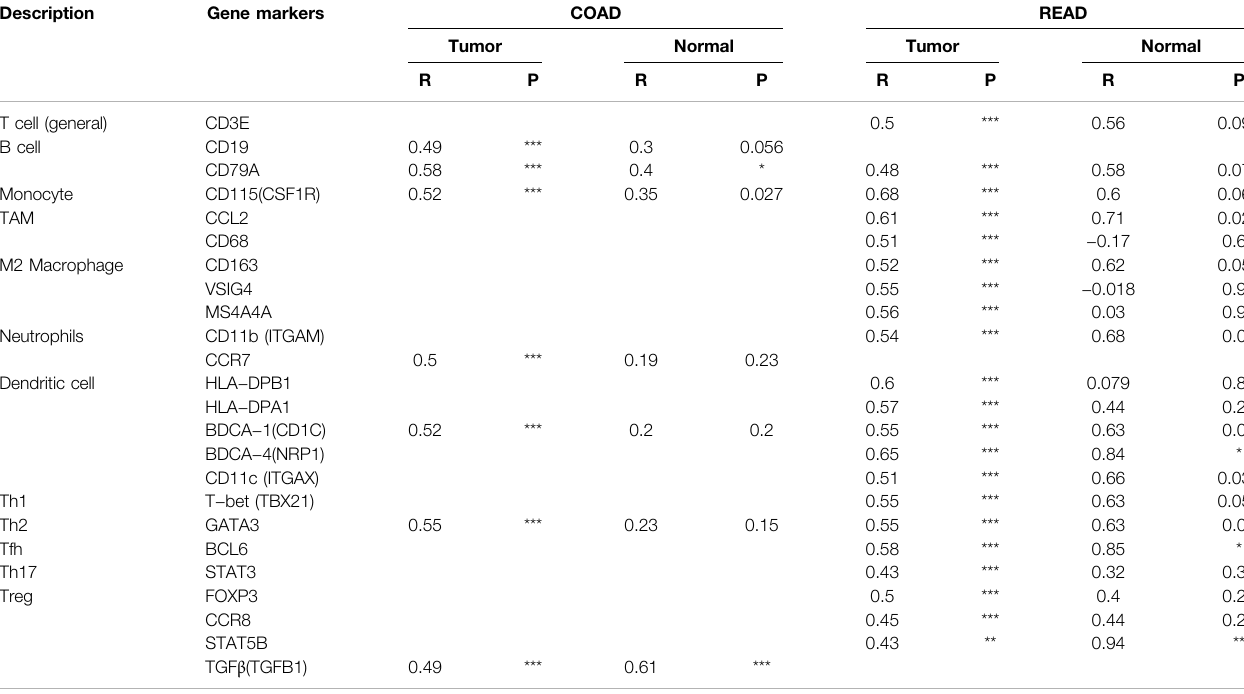
TABLE 3 | Correlation analysis between GNG7 and relate genes and markers of immune in fi ltration cells in GEPIA. Description Gene markers COAD READ Tumor Normal Tumor Normal